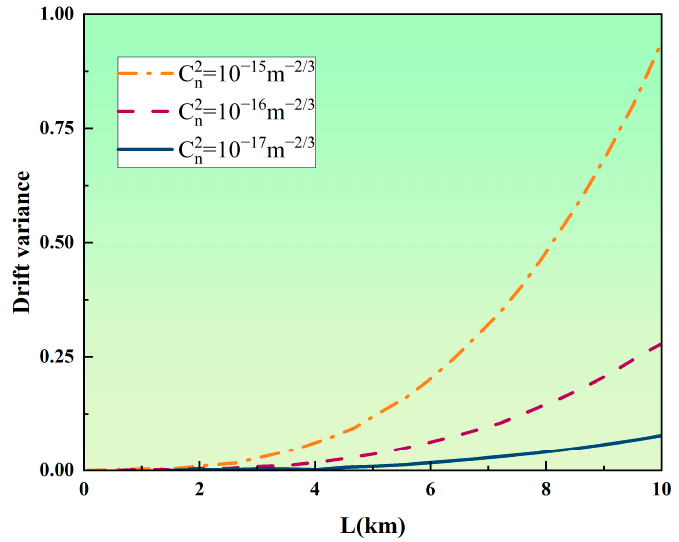
Figure 10. The impact of beam wavelength on the beam width and coherence length and their ratio in turbulent